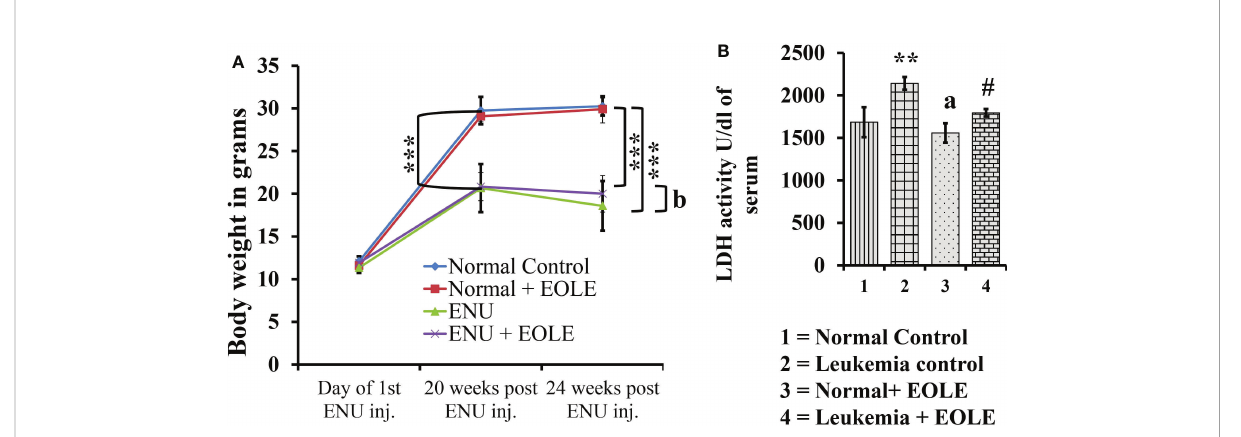
FIGURE 4 The fi gures show the effect of EOLE treatment on the health parameter of mice, where (A) Effect on body weight. Values are expressed as mean ± SD for 6 mice. (B) Lactate dehydrogenase activity (LDH) assay. Values are expressed as mean ± SD of 3 different observations. The statistical signi fi cance was tested using one-way ANOVA following Tukey ’ s multiple comparison tests by comparing the values as, Group-1 vs . Group-2, 3; Group-2 vs . Group- 4. P-value, p < 0.05 was considered as statistically signi fi cant (n = 6).When compared with Group-1 the level of signi fi cance was denoted as, a = not signi fi cant when p > 0.05; * when p < 0.05; ** when p < 0.01; and *** when p < 0.001. When compared with Group-2, b = not signi fi cant when p > 0.05; # when p < 0.05; ## when p < 0.01; and ### when p <